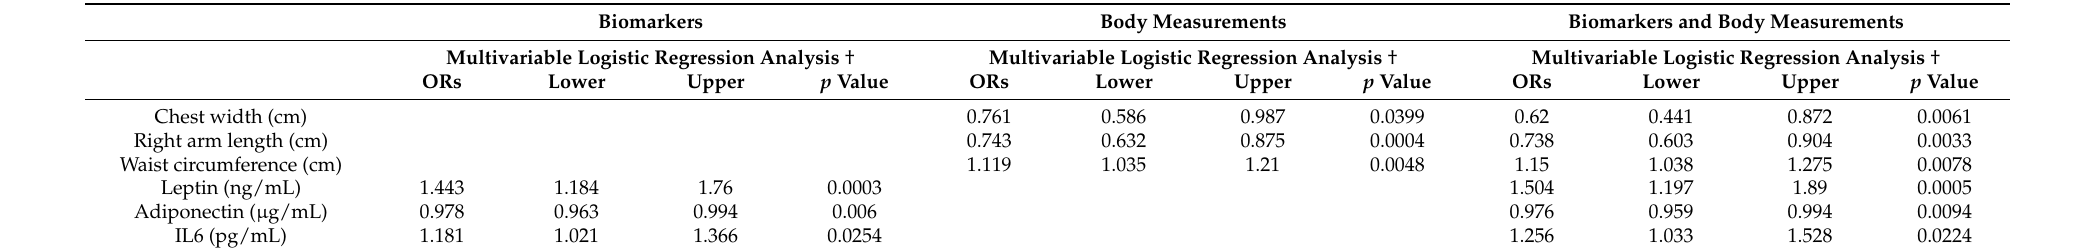
Table 5. Multiple logistic regression analysis of developing